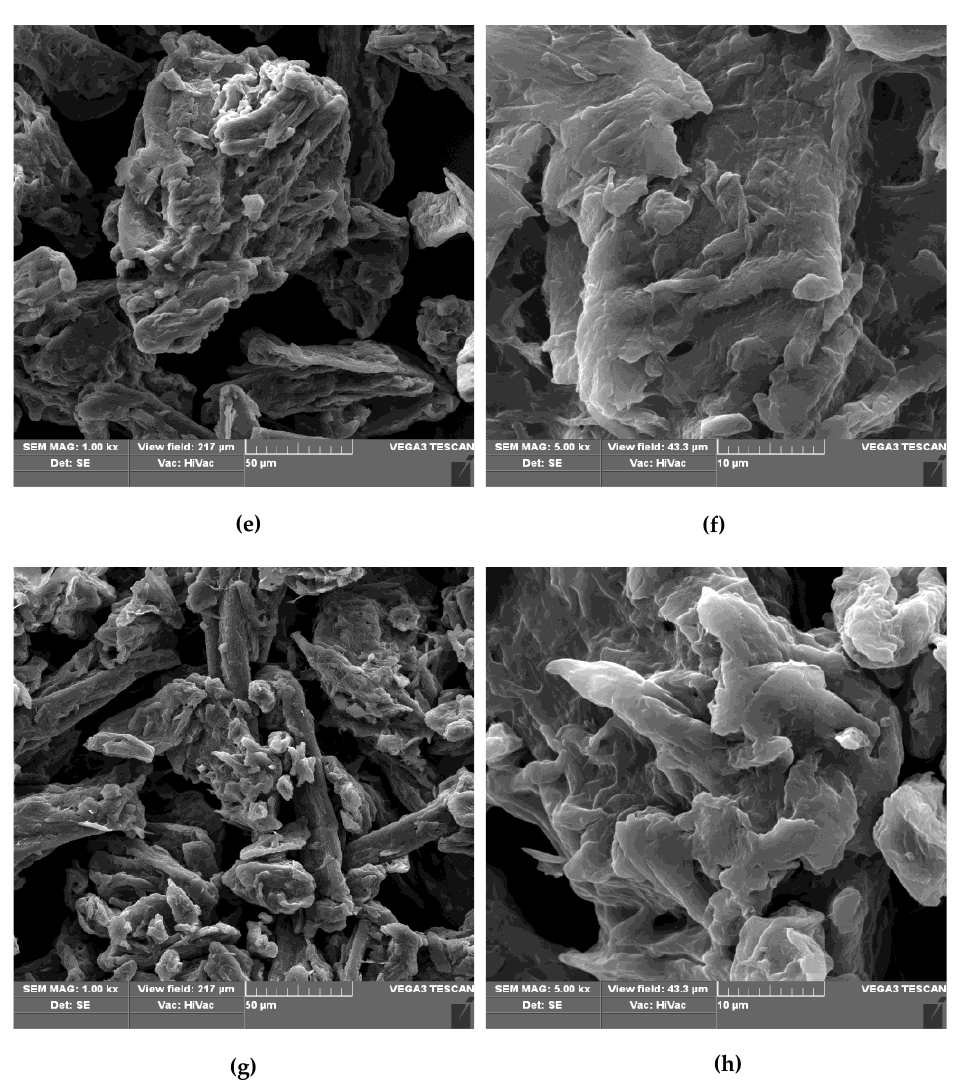
Figure 9. Scanning electron microscopy (SEM) micrographs of different magnifications (1 k and 5 k) for: ( a , b ) unmodified cellulose microcrystalline; ( c , d ) phosphorylated cellulose by PCl 3 after 48 h reaction time and work-up (Cell- O 6 -P(O)(OH)- H(48 h)); ( e , f ) phosphorylated cellulose by PCl 3 after 72 h reaction time and work-up (Cell- O 6 -P(O)(OH)-H(72 h)); and, ( g , h ) cellulosic Cu-complex (Cell- O 6 -P(O)(O - )-H × Cu 2+ (48 h).